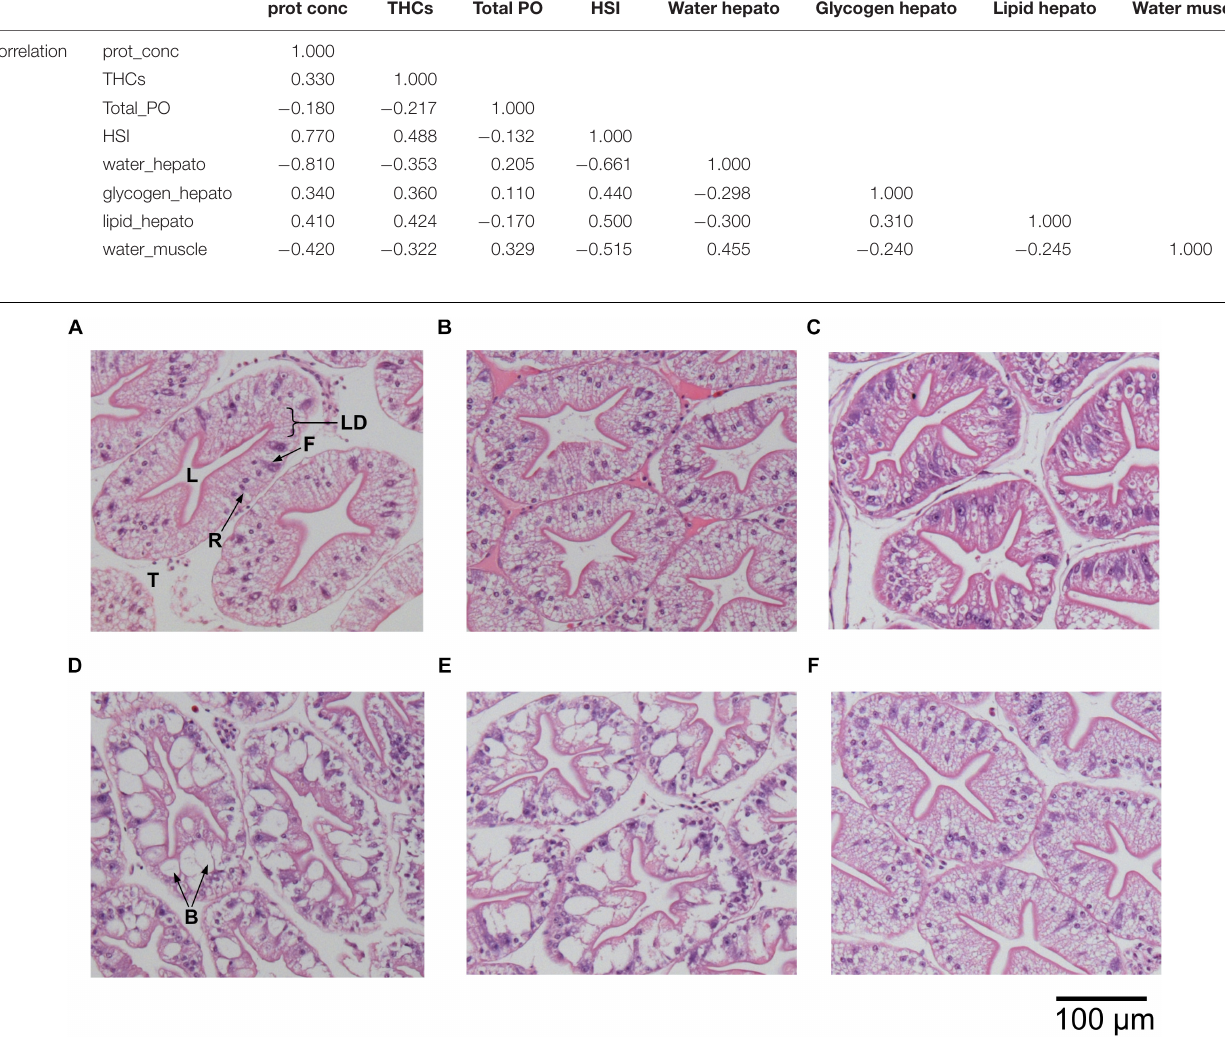
FIGURE 3 | Histological cross sections of hepatopancreas tubules of H. gammarus (stained with hematoxylin and eosin) after being held for 24 weeks under different conditions. (A) 12 fed; (B) 8 fed; (C) 4 fed; (D) 12 fasted; (E) 8 fasted, and (F) 4 fasted. B, B-cell vacuole; F, F-cell; L, lumen; LD, lipid droplet; R, R-cell; T, tubule. Scale bar 100 µ